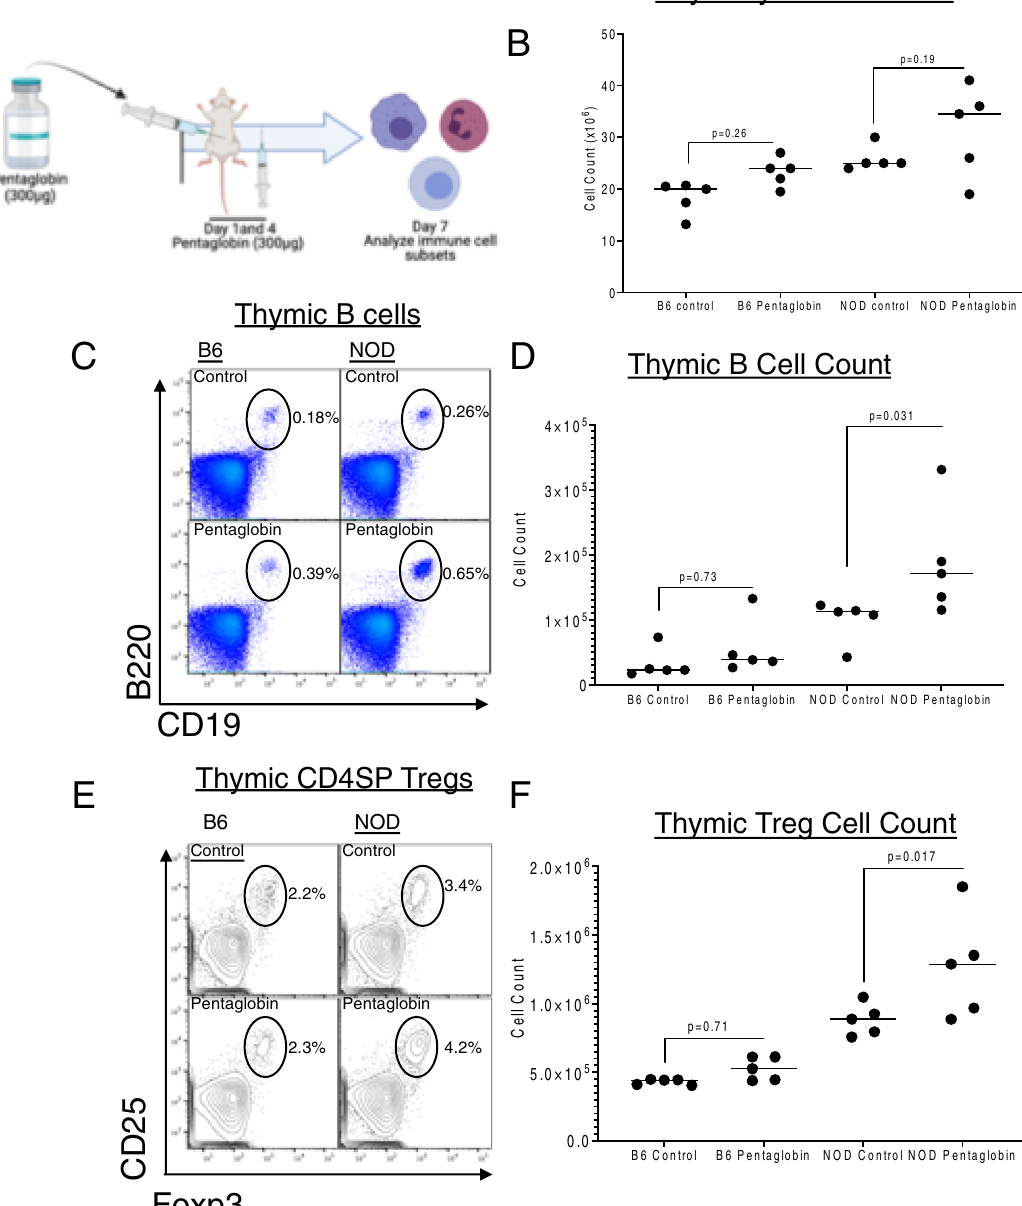
Figure 2. Pentaglobin expands thymic B cell and Treg numbers. ( A ) Previous studies demonstrate healthy donor IgM expands thymic B cells and Tregs to drive diabetes reversal. To determine the immunologic changes induced by Pentaglobin, we delivered 2, 300ug doses into B6 mice and prediabetic NOD mice. Mice were euthanized on day 10 and thymus and spleen isolated for flow analysis. ( B ) Total thymocyte cell counts revealed an increase in NOD mice treated with Pentaglobin. ( C ) This increase was linked to an expansion of thymic B lymphocytes in NOD mice. Quantified in ( D ). ( E ) Expansion of thymic B cells has been linked to thymic Treg expansion in other models. Flow cytometry was used to identify Foxp3 + CD25 + CD4 single-positive cells among B6 and NOD thymocytes. Thymic Tregs were expanded in NOD mice treated with Pentaglobin. Total cell counts demonstrated in ( F